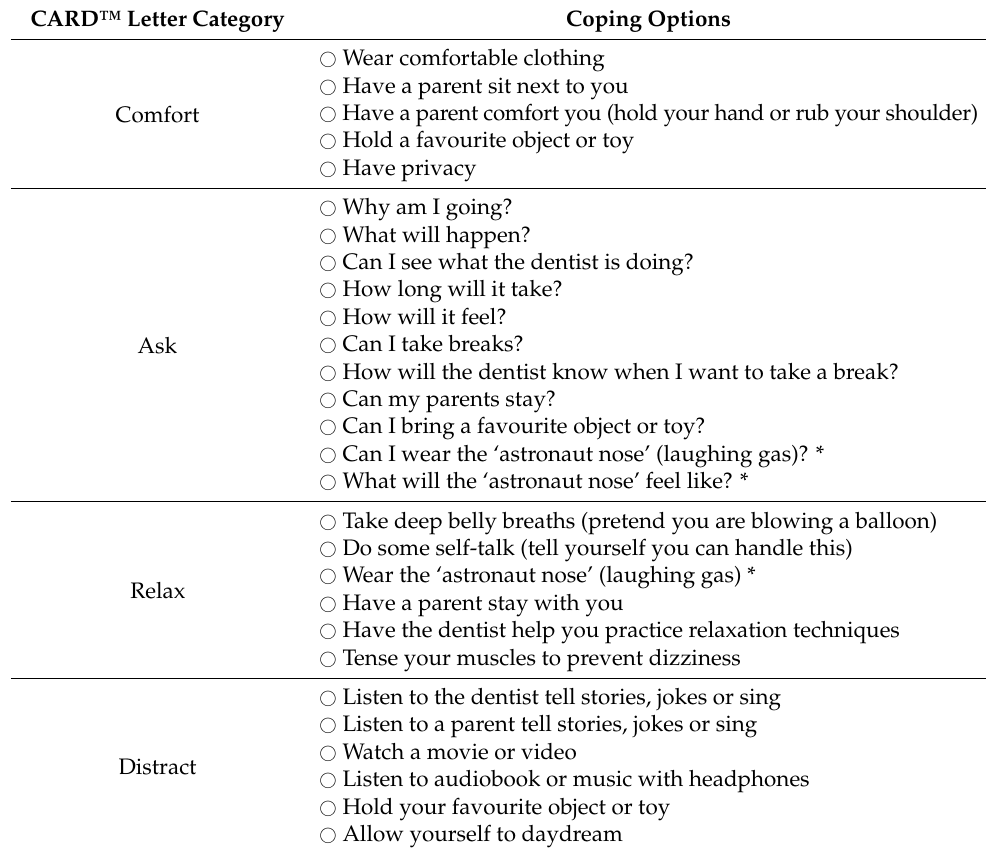
Table 2. CARD™ (Comfort Ask Relax Distract) options provided to participants during the interview. CARD™ Letter